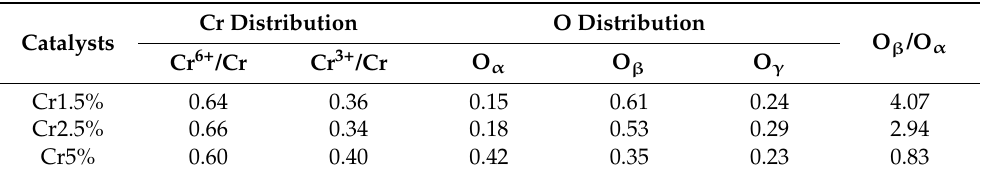
Table 5. Distributions of chromium and oxygen species. Catalysts